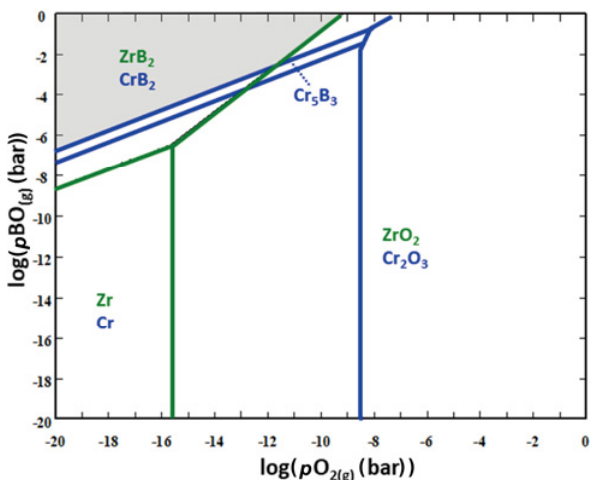
Fig. 13 Predominance stability diagrams for the Zr–B–O and Cr–B–O systems at 1900 ℃ highlighting in grey shaded area the partial pressure conditions within the hot press chamber that yield precipitation of borides into the matrix grains.